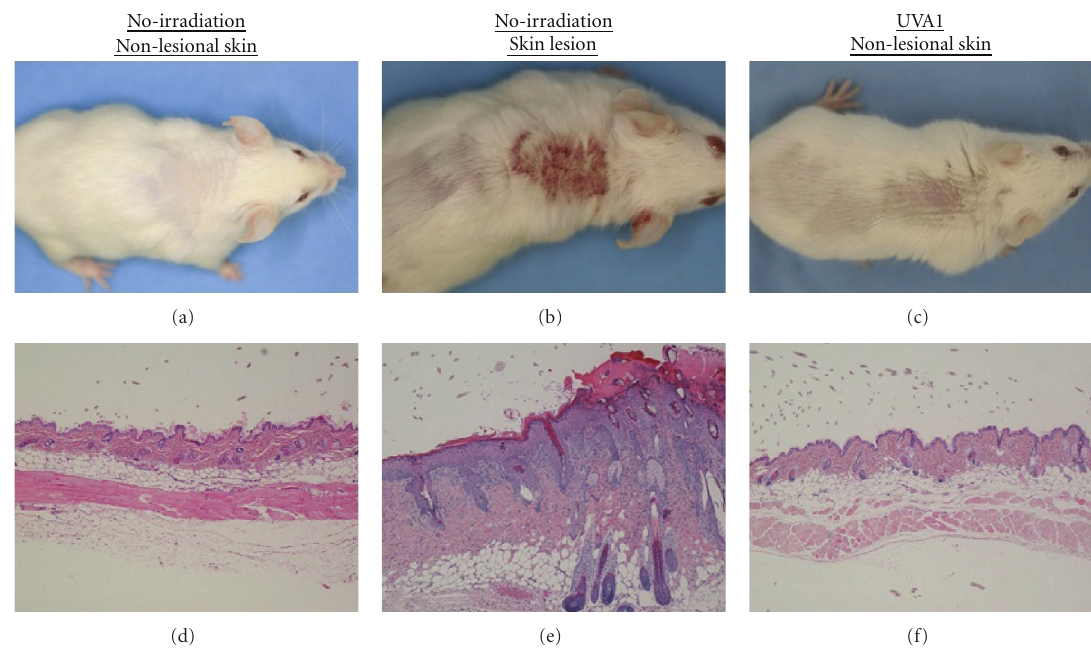
Figure 1: Macroscopic and histopathological findings of the skin representative of MRL/lpr mice. (a), (d): nonlesional skin of nonirradiated mice. (b), (e): spontaneous LE-like skin lesion of nonirradiated mice. (c), (f): nonlesional skin of UVA1-irradiated (10J/cm 2 ) mice. As shown in Table 1, some of the nonirradiated MRL/lpr mice developed LE-like skin lesions with alopecia and scab formation (b). In the spontaneous LE-like skin lesions, histopathologically, acanthosis with hyperkeratosis, liquefaction, and mononuclear cell infiltrations into the dermis were noted (e). On the other hand, none of the UVA1-irradiated mice showed LE-like skin lesions (c). Most of the nonlesional mice did not show any histological changes (d), (f). (d), (e), (f): HE stain, original magnification, ×